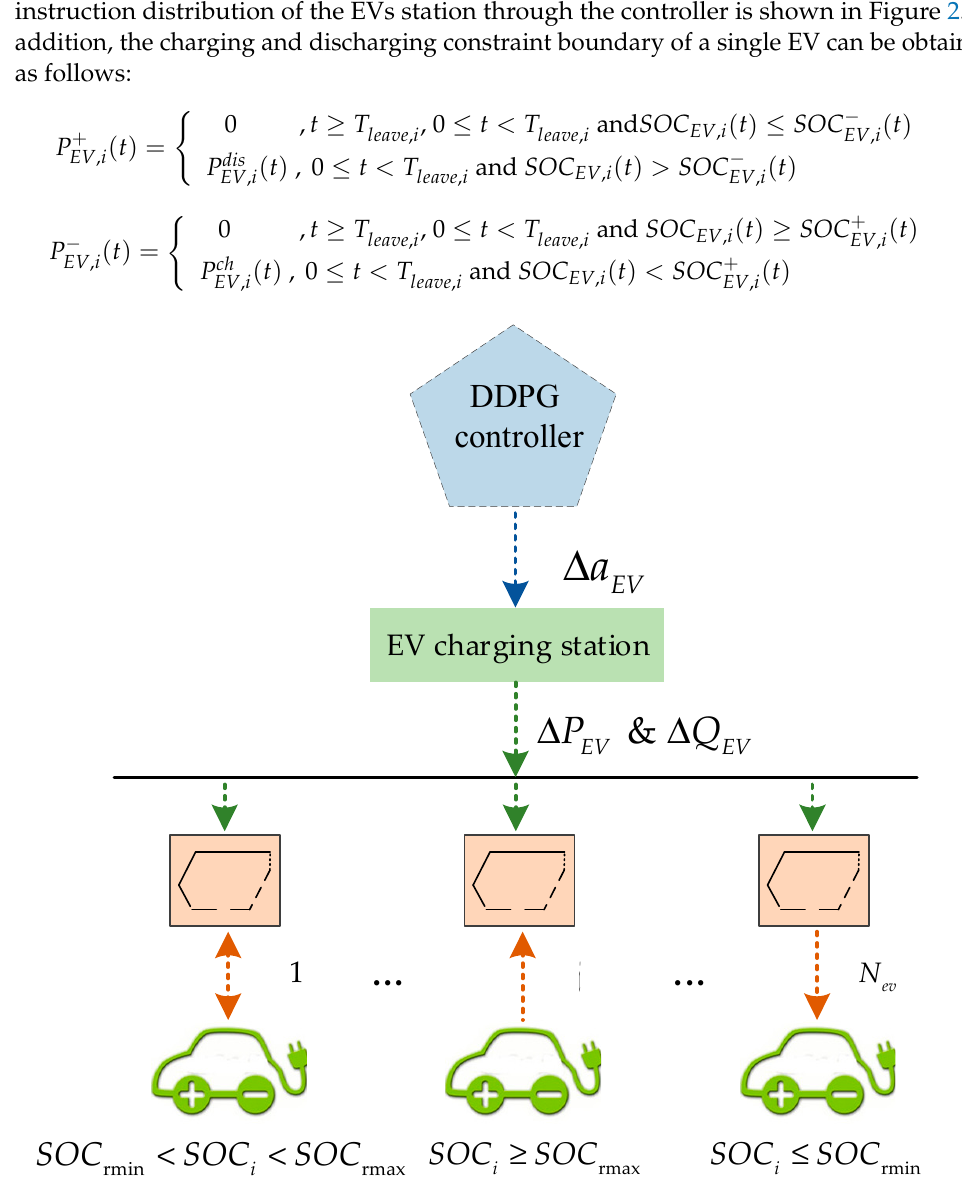
Figure 2. The distribution of controller commands in the charging station.